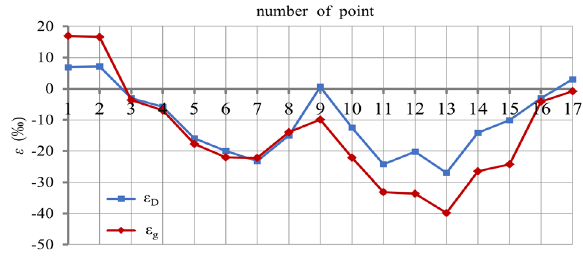
and ε for x = 0 m in the g D p